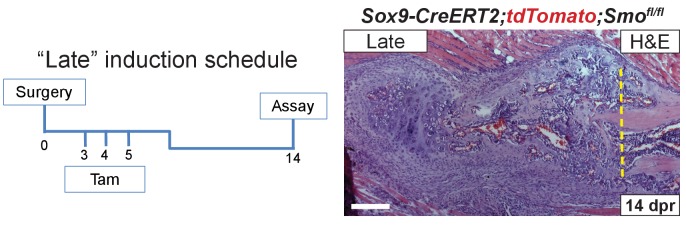
Late KO of Smo.‘Late’ tamoxifen induction schedule: Sox9-CreERT2;tdTomato;Smofl/fl mice were injected with tamoxifen days 3–5 post resection. H and E staining at 14 dpr shows ample trabecular bone and cartilage formation. Although repair is delayed when compared to control mice, there is much more bone and cartilage formation when compared to either the Pre or Post KO calluses at 14 dpr (n = 3).